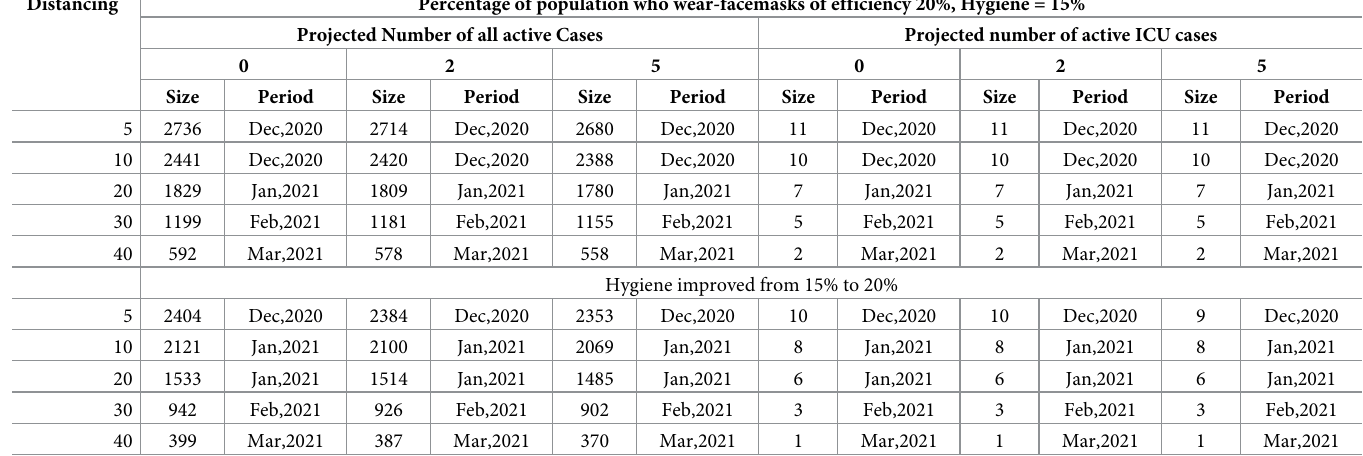
Table 7. Summary of predicted numbers of active COVID-19 and ICU cases (in thousands) under different adherence levels of mask wearing and physical distanc- ing in the rural population of Ethiopia. Distancing